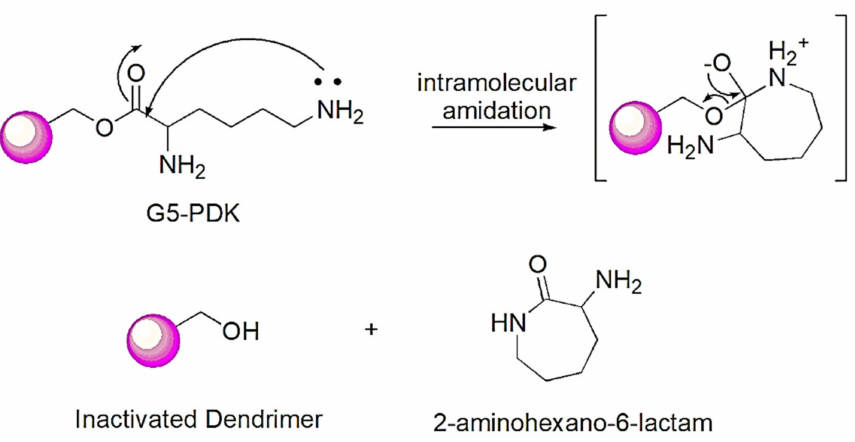
Scheme 4. Mechanism of G5-PDK inactivation through self-degradation by an intramolecular amidation